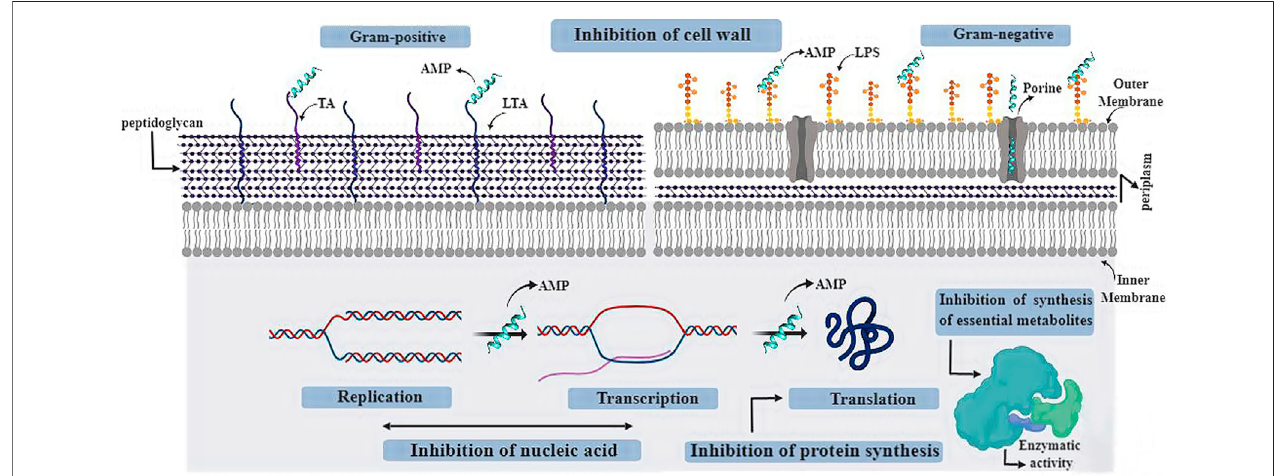
FIGURE 5 | Illustration of the main molecular targets of AMPs already described. AMP, antimicrobial peptide; TA, teichoic acid; LTA, lipoteichoic acid.